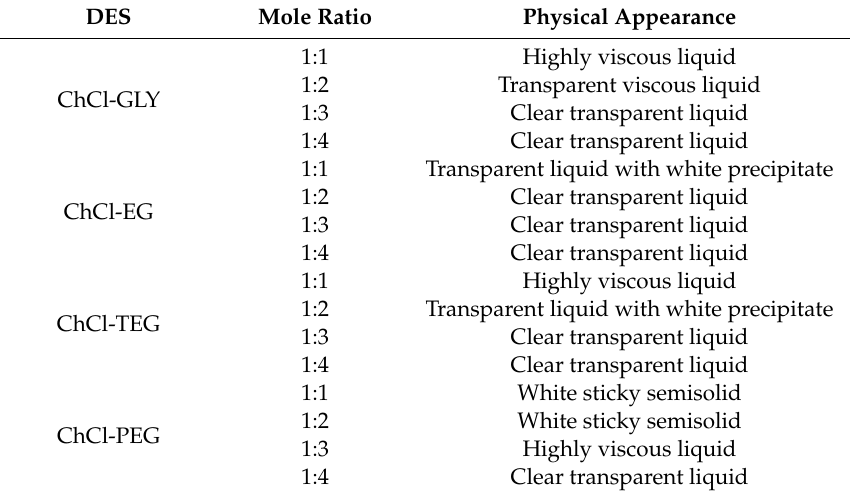
Table 3. Physical description of synthesized DES under room